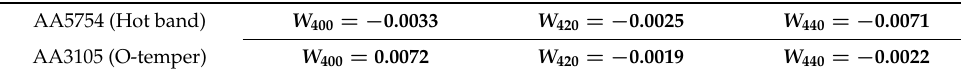
Table 2. Texture coefficients W lmn of two aluminum alloys.